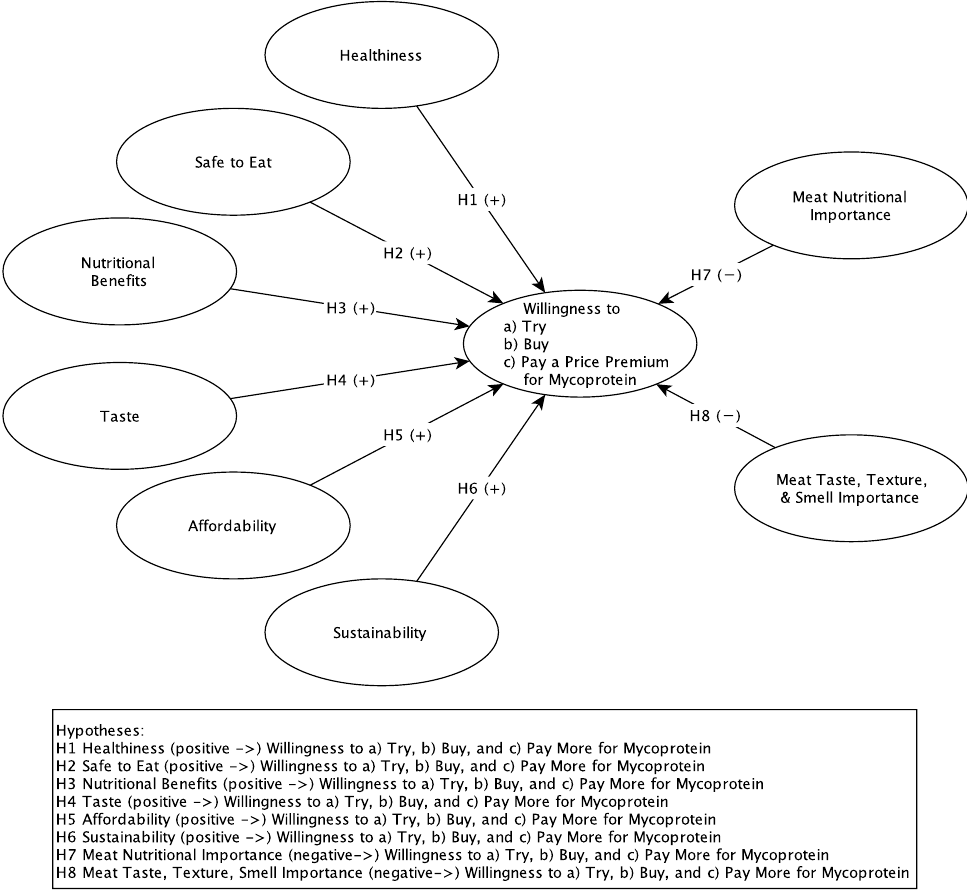
Figure 1. Conceptual Model.